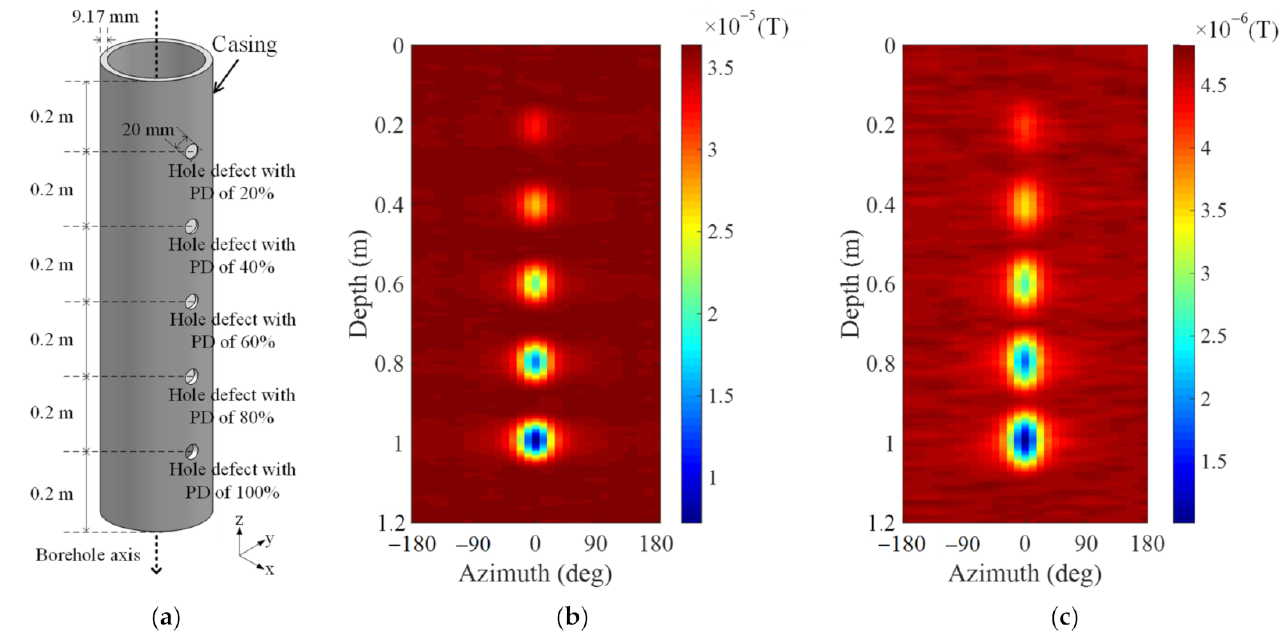
Figure 10. Casing structure with five asymmetry hole-type defects and inspection results of the synthesized UCA: ( a ) Casing structure; ( b ) inspection results at 10 ms; ( c ) inspection results at 20